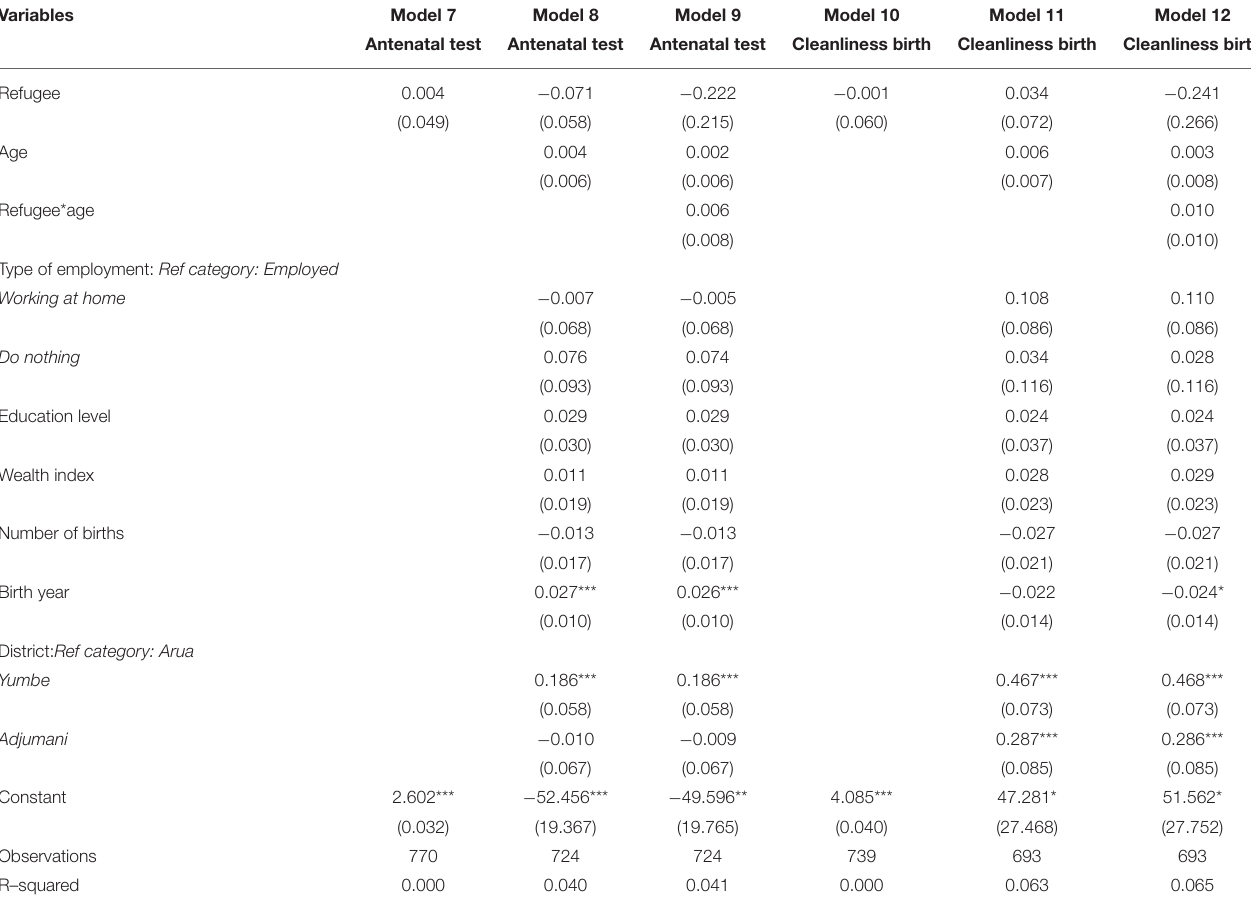
TABLE 3 | OLS regression testing the quality of services and refugee